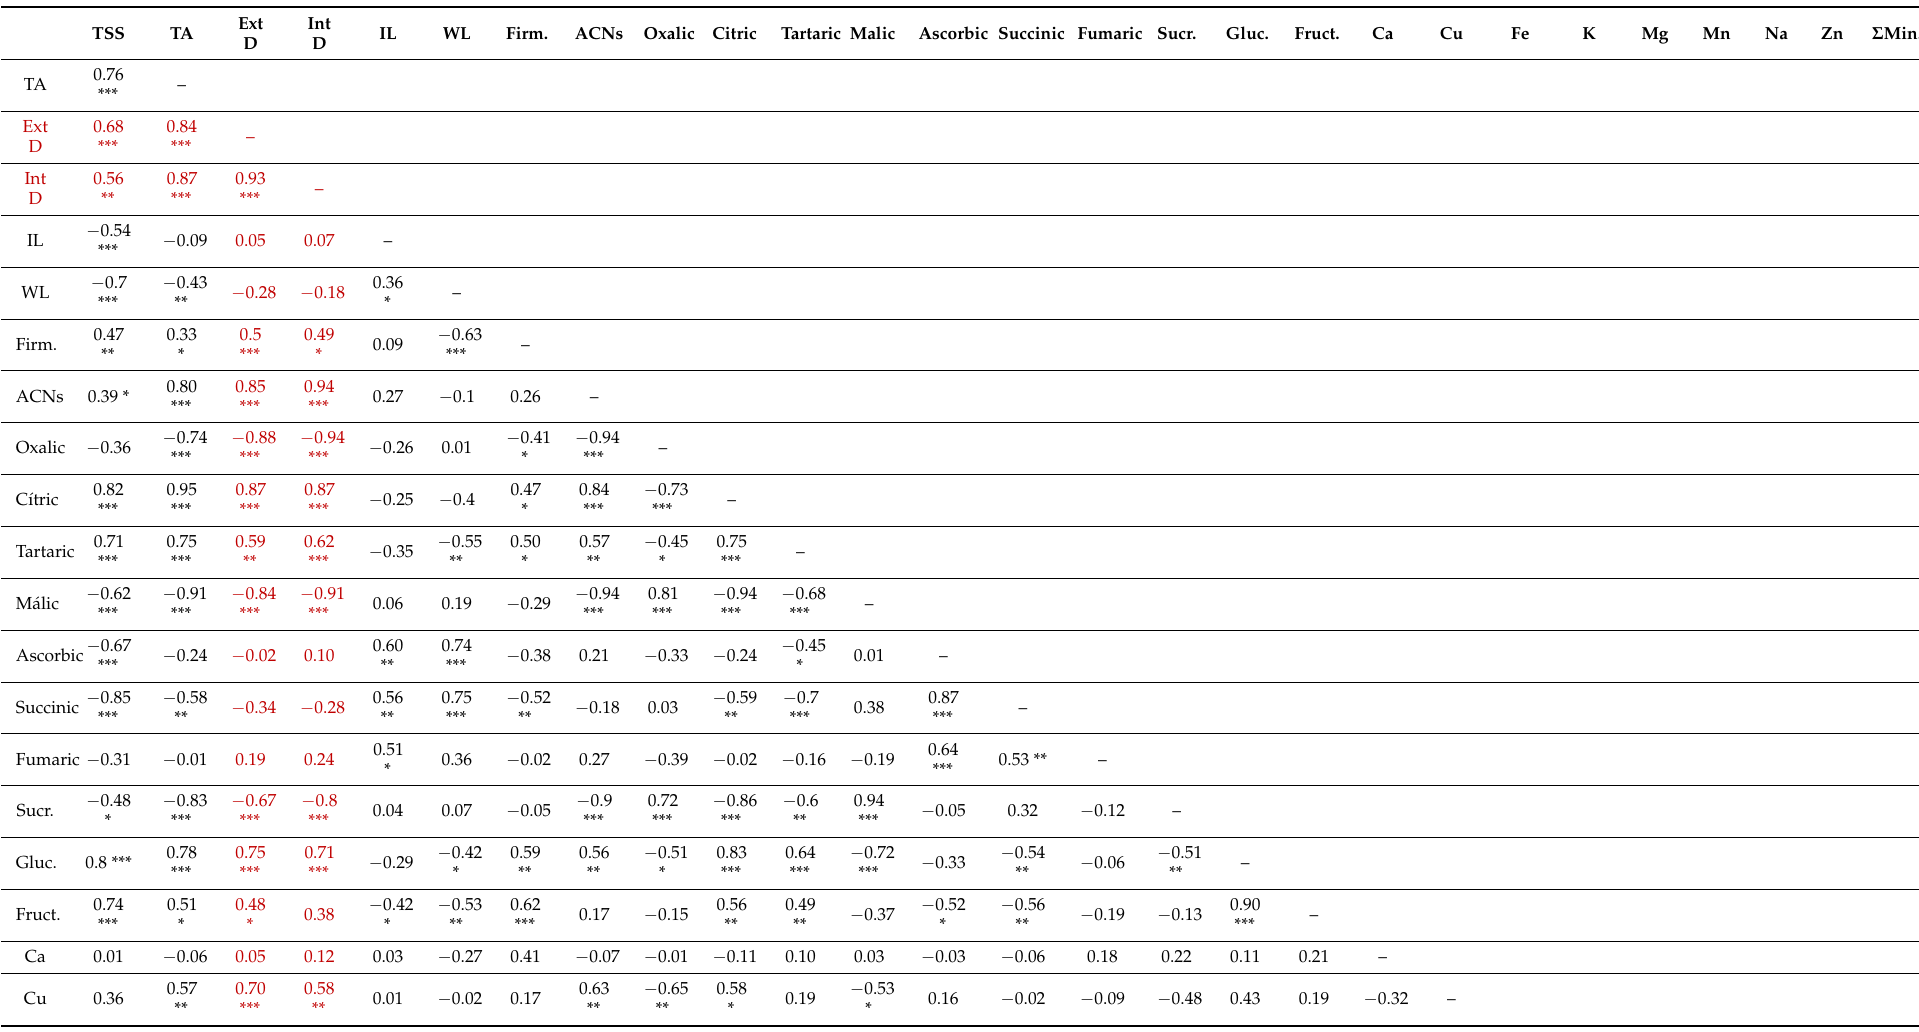
Table 2. Pearson correlation between dependent variables of fruit after storage for 30 d at 2 ◦ C plus 20 d at 20 ◦